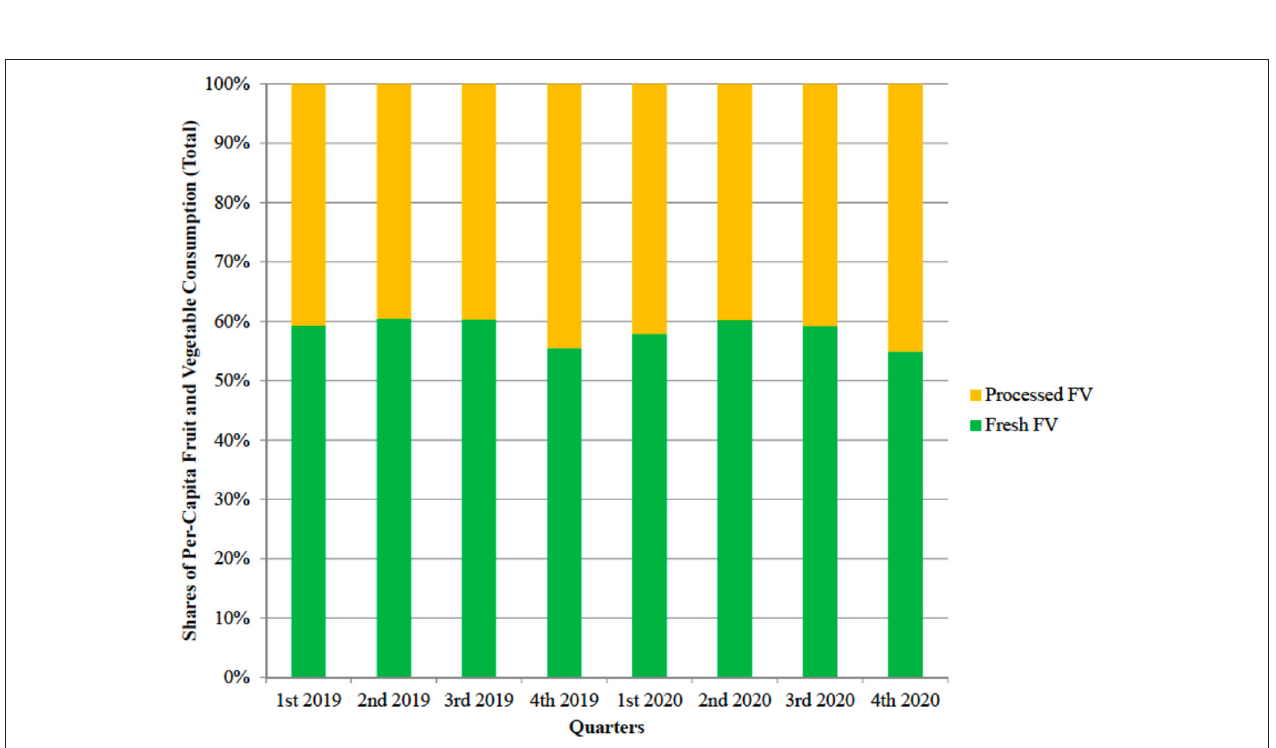
FIGURE 6 | Break down of per-capita expenditure for fruit and vegetables (total) into expenditure shares for fresh fruit and vegetables and processed fruit and vegetables (per-cent shares, UK, years 2019–2020).